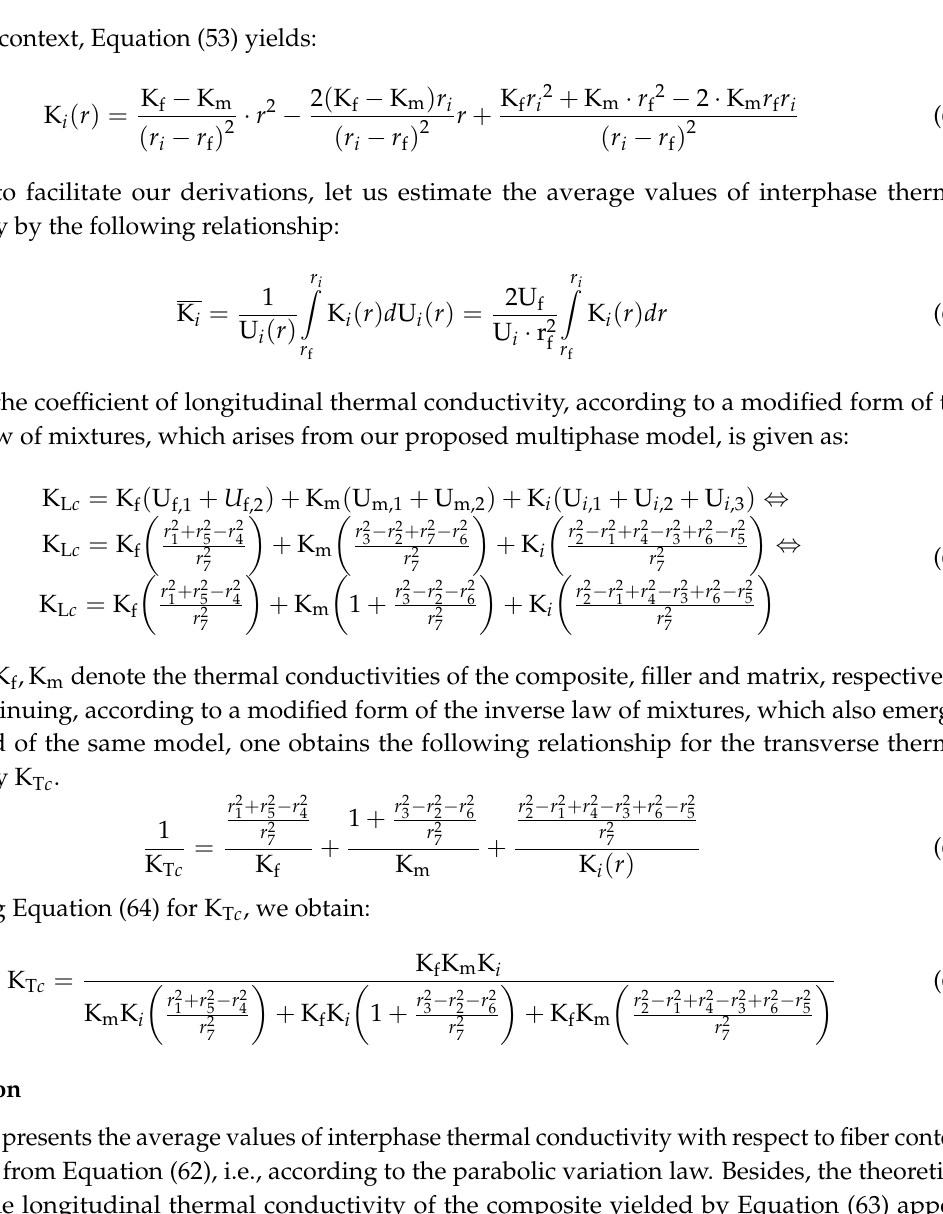
Table 3. Longitudinal thermal conductivity of the composite for various filler contents.